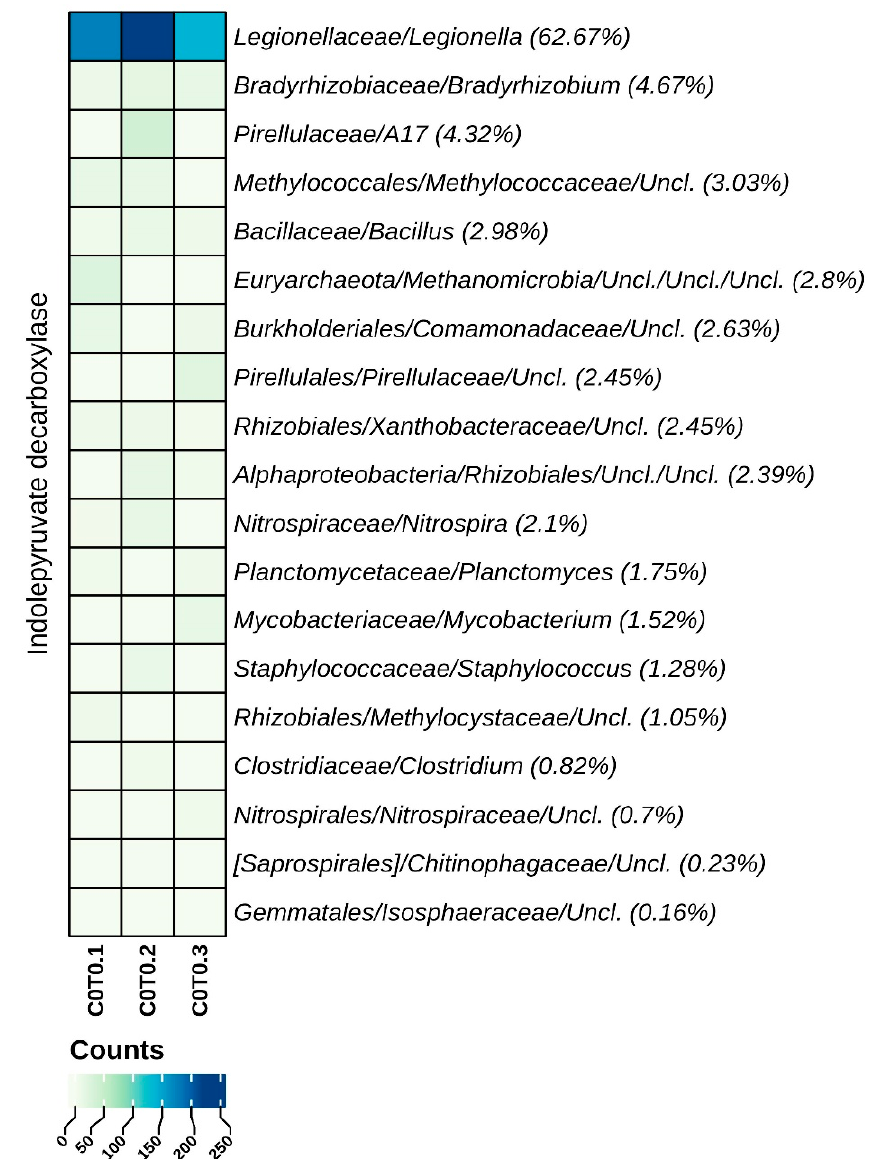
Figure 10. Functional Heatmaps of the indole-3-pyruvate decarboxylase identified ASVs aggregated at the Genus level, as inferred by PICRUSt2 in the three biological replicates. On rows, the nearest identified taxonomic level for each contributing ASV is reported, followed by its relative percentage contribution to the functional feature. Hierarchical clustering of columns was performed by Pearson correlation, based on Euclidean distance.